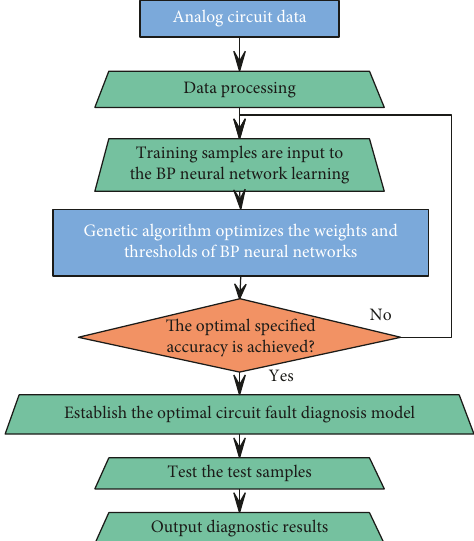
Figure 6: Performance optimization system of electronic com- ponents based on improved